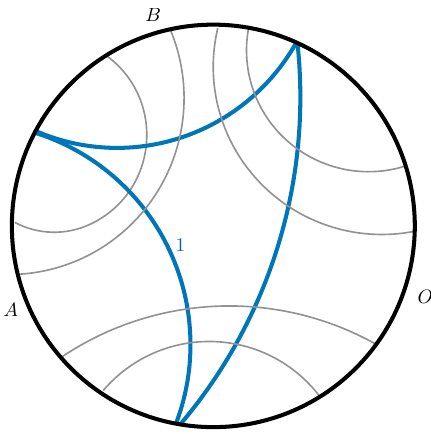
Figure 5 . When we have multiple boundary regions we include a species of bit thread for each pair of boundary regions. The minimal barrier configuration ν ∗ consists of placing a barrier of one on each of the single party RT surfaces such that each thread crosses a barrier of